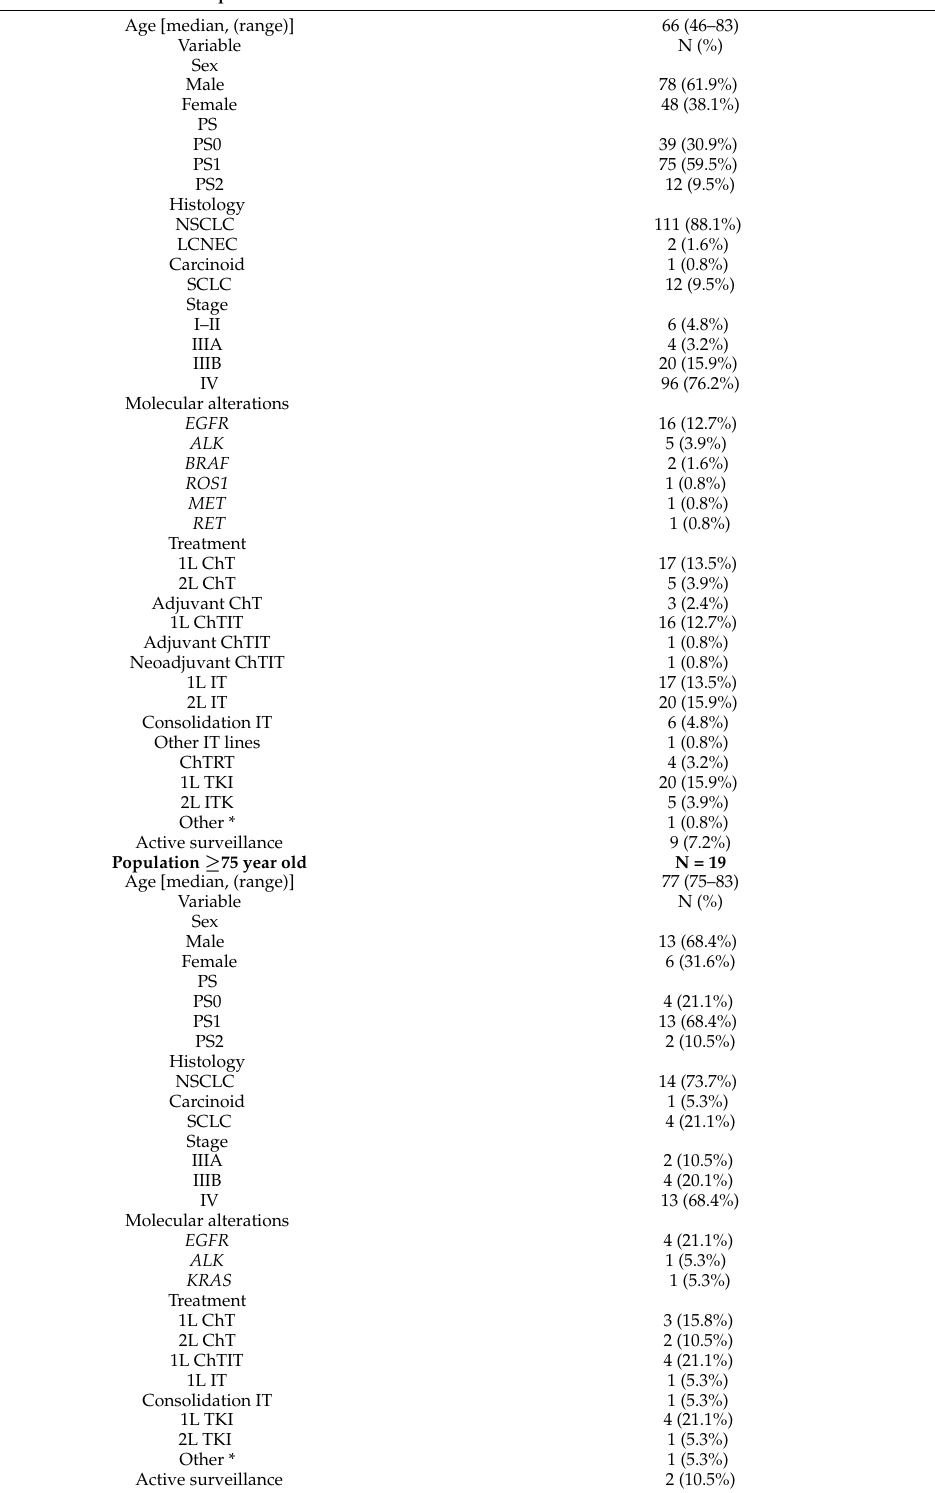
Table 1. Demographic and tumor-related variables of a total of 126 lung cancer patients and 19 patients aged ≥ 75 included in the study. Legend: 1L first line: 2L second line, ChT, chemotherapy; IT, immunotherapy; LCNEC, large cell neuroendocrine carcinoma; NSCLC, non-small cell lung cancer; PS, performance status; RT, radiotherapy; SCLC, small cell lung cancer; TKI, tyrosine kinase inhibitor. * Other includes lantreotide. Bold: specific information on population >75